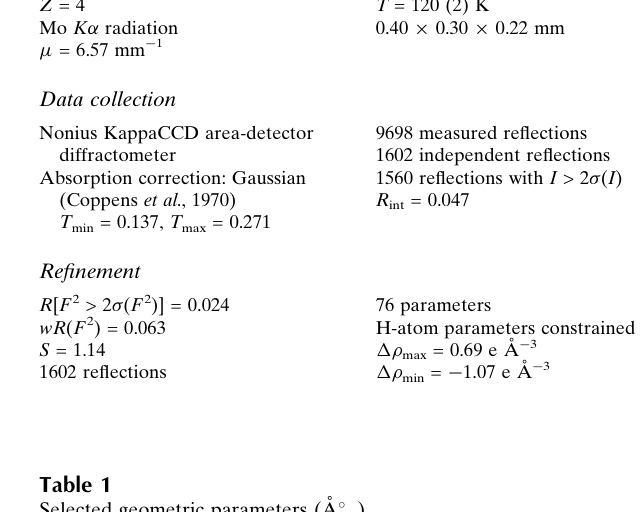
Selected geometric parameters (A˚ (cid:1) ,